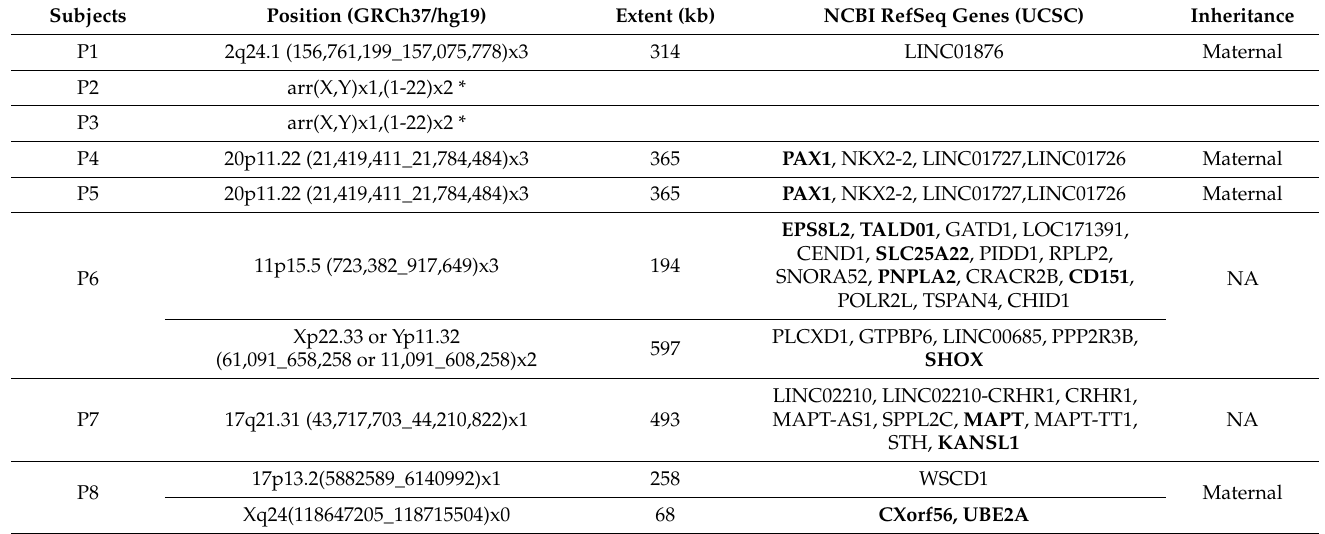
Table 6. Genetic abnormalities on array-CGH of the